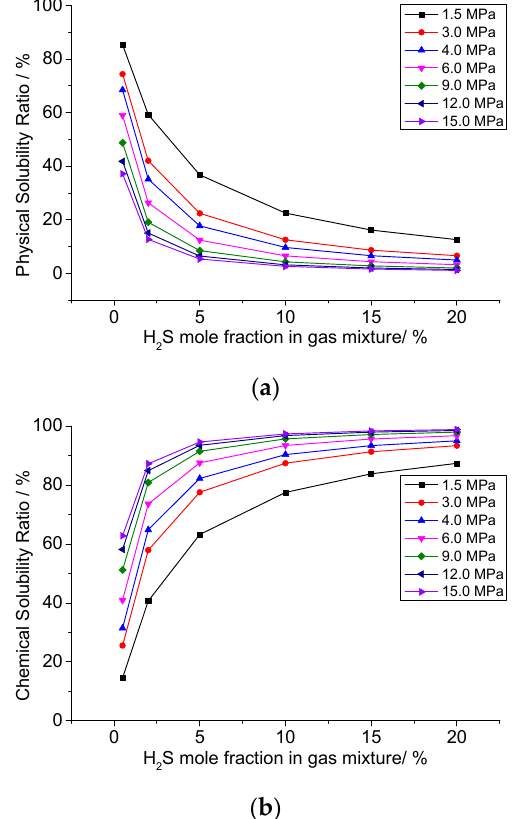
Figure 13. Curves of the percentage changes in physical and chemical solubility. ( a ) 293.15 K physical solubility; ( b ) 293.15 K chemical solubility. The short, dashed line in Figure 14 represents the percentage of chemical solubility of elemental sulfur, and the solid line with the same color as the dashed line represents the percentage of physical solubility of elemental sulfur. Overall, as the molar fraction of H 2 S in the gas increased, the proportion of chemical solubility increased. Only when the molar content of H 2 S was small and the pressure was low did the proportion of physical solubility dominate. In addition, above this H 2 S molar content, the main solution mechanisms of elemental sulfur were dominated by chemical solution.